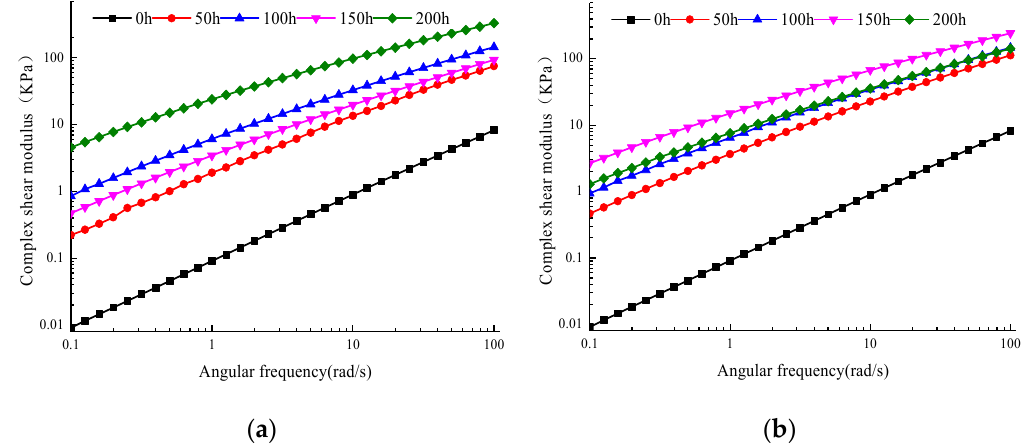
Figure 8. Main curve of complex shear modulus of WMA (70 °C). ( a ) Oxygen isolation conditions. ( b ) Oxygen-containing conditions.